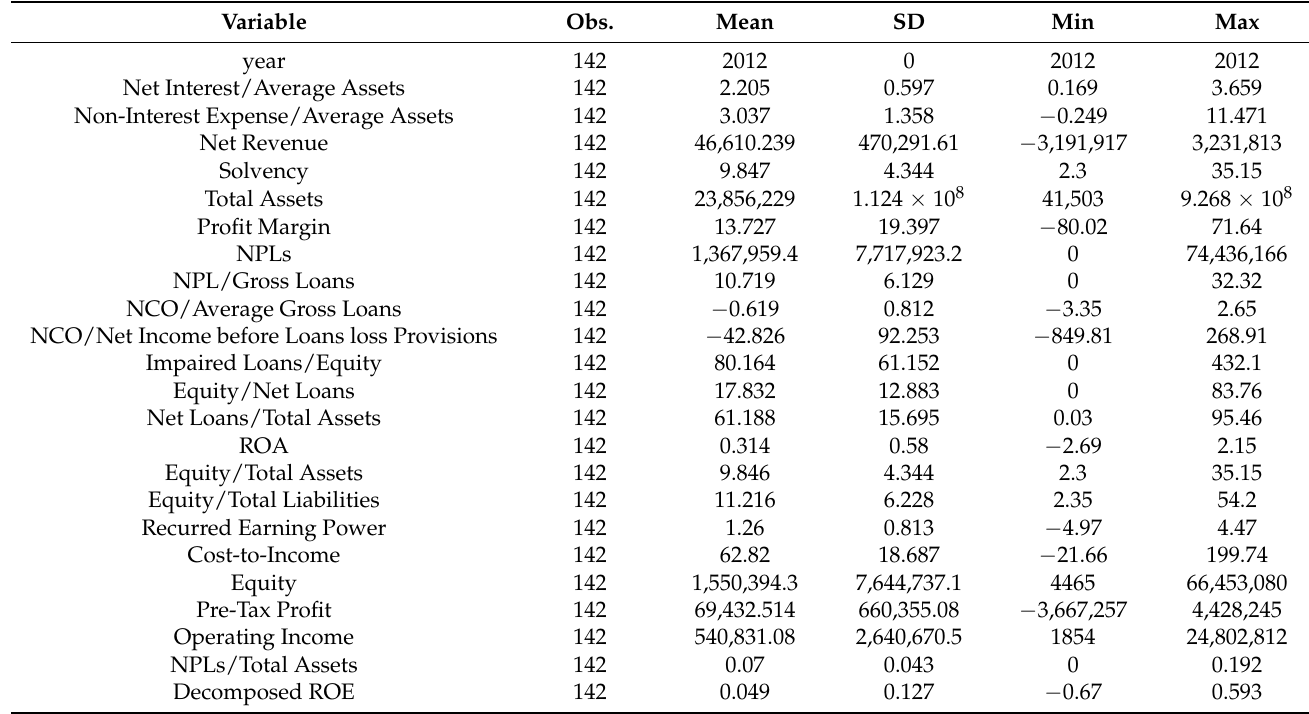
Table A2. Descriptive statistics for the 142 Italian banks for the year